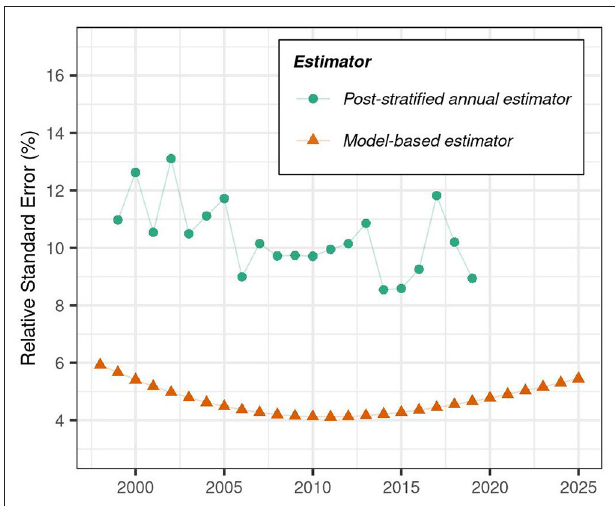
FIGURE 7 | Relative standard error (%) of model-based and post-stratified estimators of trends total merchantable wood volume on timberland in Washington County,